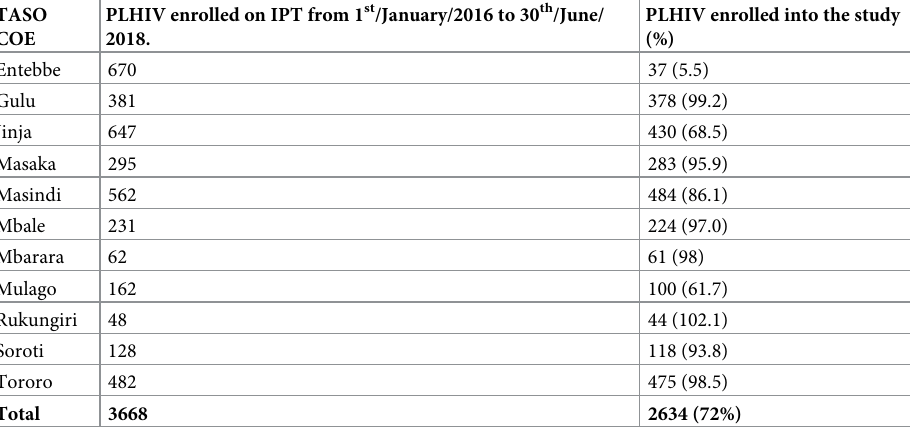
Table 1. Number of PLHIV enrolled on IPT from 1st January 2016 to 30th June 2018, and number enrolled into the study. TASO PLHIV enrolled on IPT from 1 st /January/2016 to 30 th /June/ COE 2018.